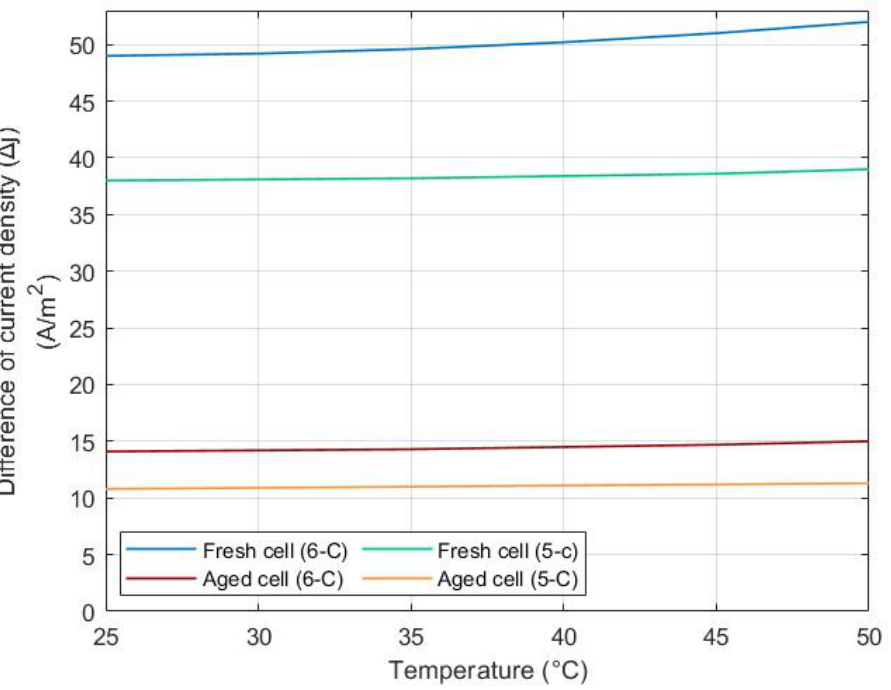
Figure 8. The effect of high ambient temperature on current density distribution during fast charging scenarios for fresh and aged